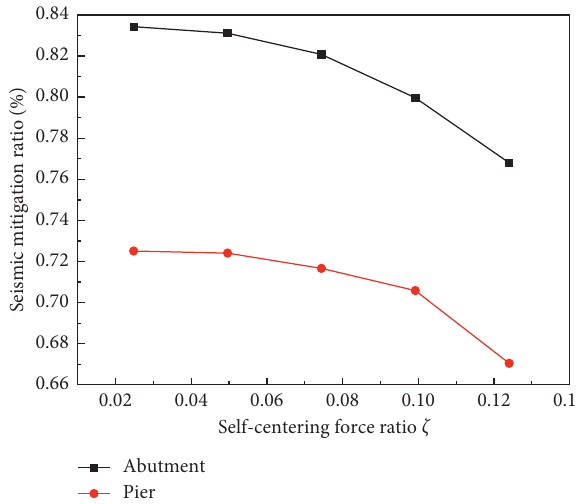
Figure 16: The relationship between seismic mitigation ratio and self-centering force